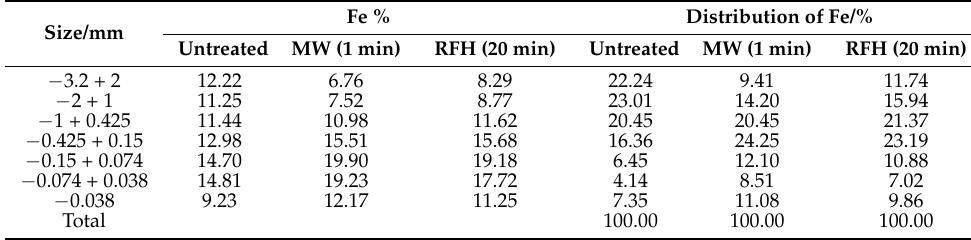
Table 7. Grade and distribution of Fe for each particle size range of the grinding